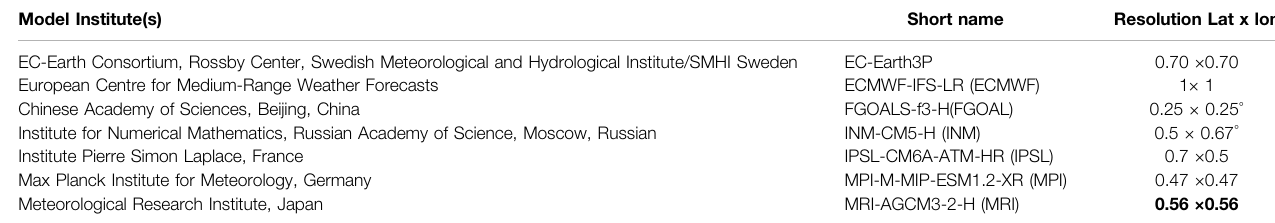
TABLE 1 | Description of the CMIP6 HighResMIP models used. Model Institute(s)